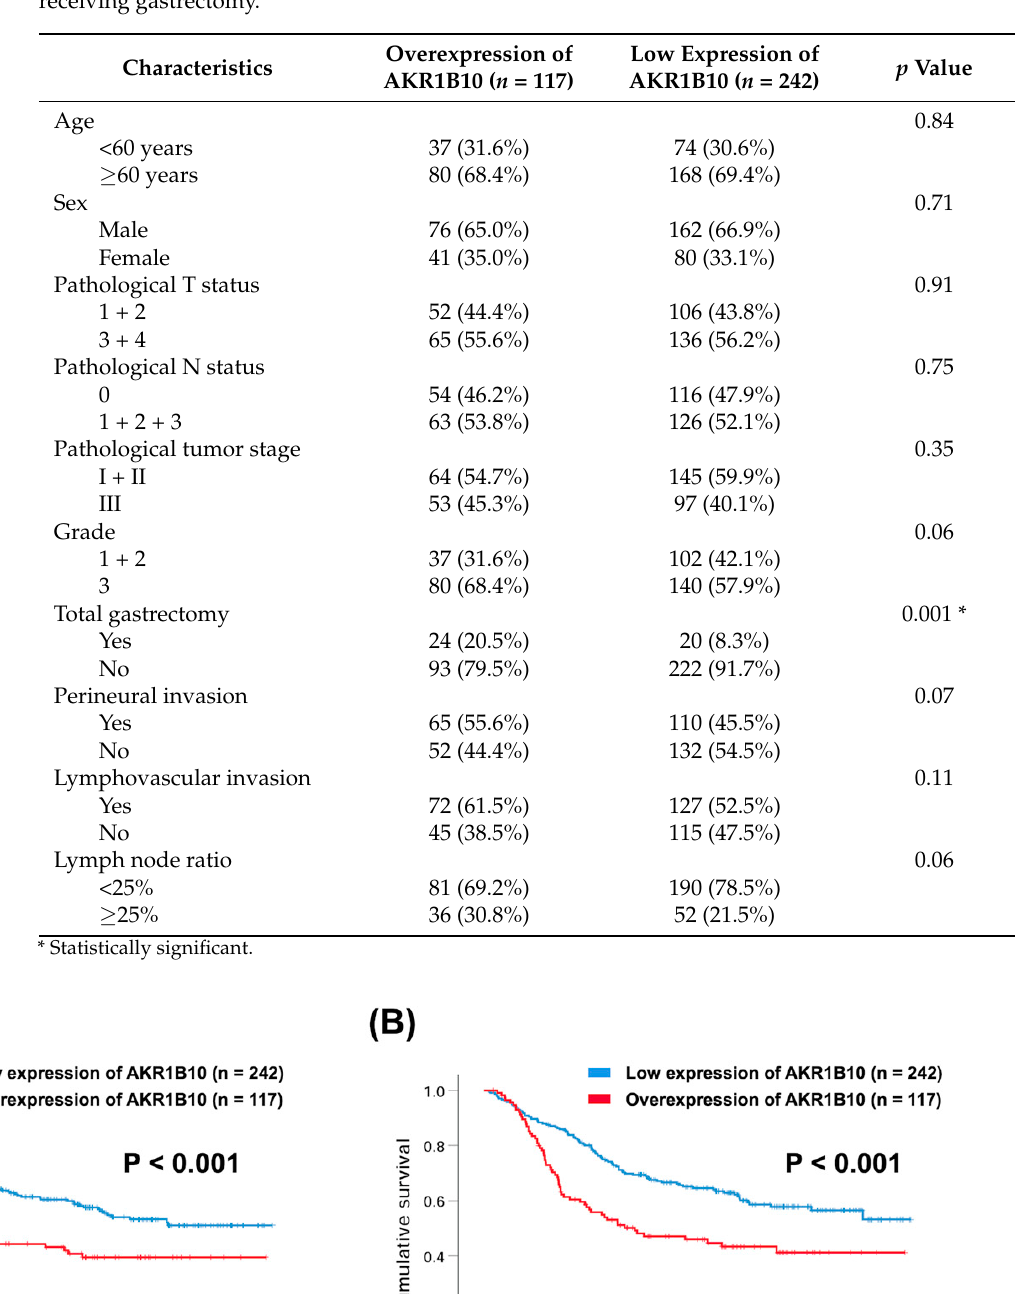
Table 2. Comparison of clinicopathological parameters in 359 gastric adenocarcinoma patients receiving gastrectomy.